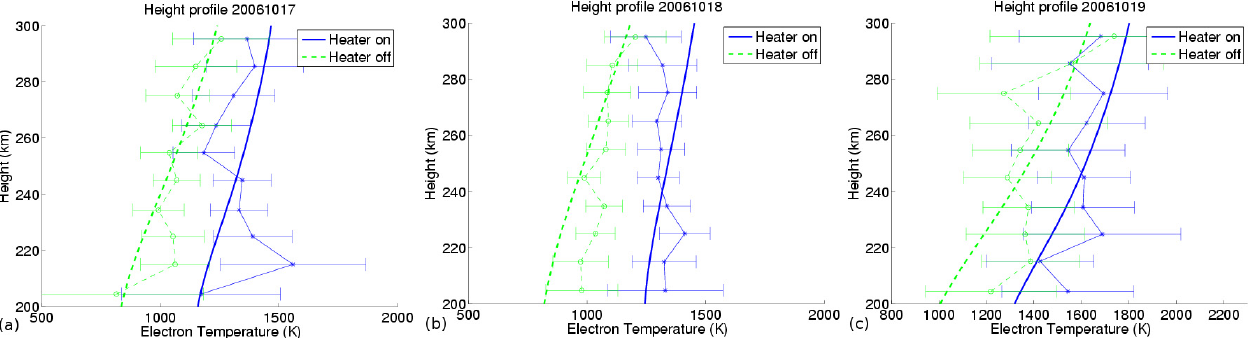
Fig. 2. Temporal evolution of the electron temperature for the three different days, (a) 17 October, (b) 18 October and (c) 19 October. Temperatures derived from conditionally averaged raw radar data,received at the same offset time from the nearest HF on time, are plotted vs. time along with the error bars. Exponential fits to temperature rise and fall are shown in green. Results of the time dependent modeling of collisional Ohmic heating by the pump wave are shown in red (see text).